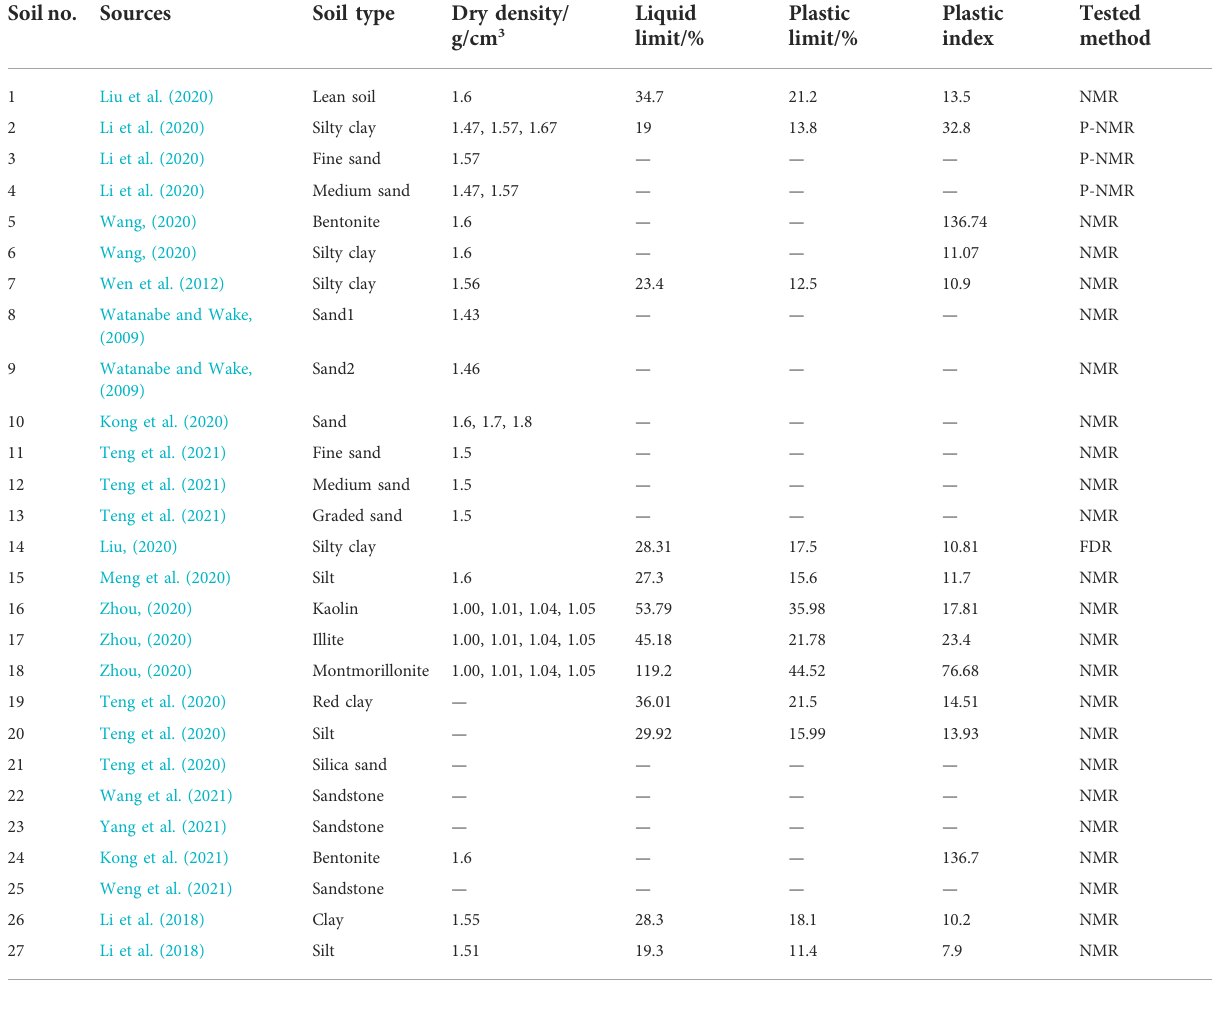
TABLE 1 Overview of the compiled unfrozen water content dataset. Soil no.